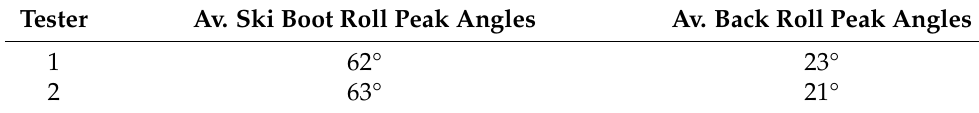
Figure 9. Roll angle for the ski boots and for the back. Table 5. Average roll angles for ski boots and